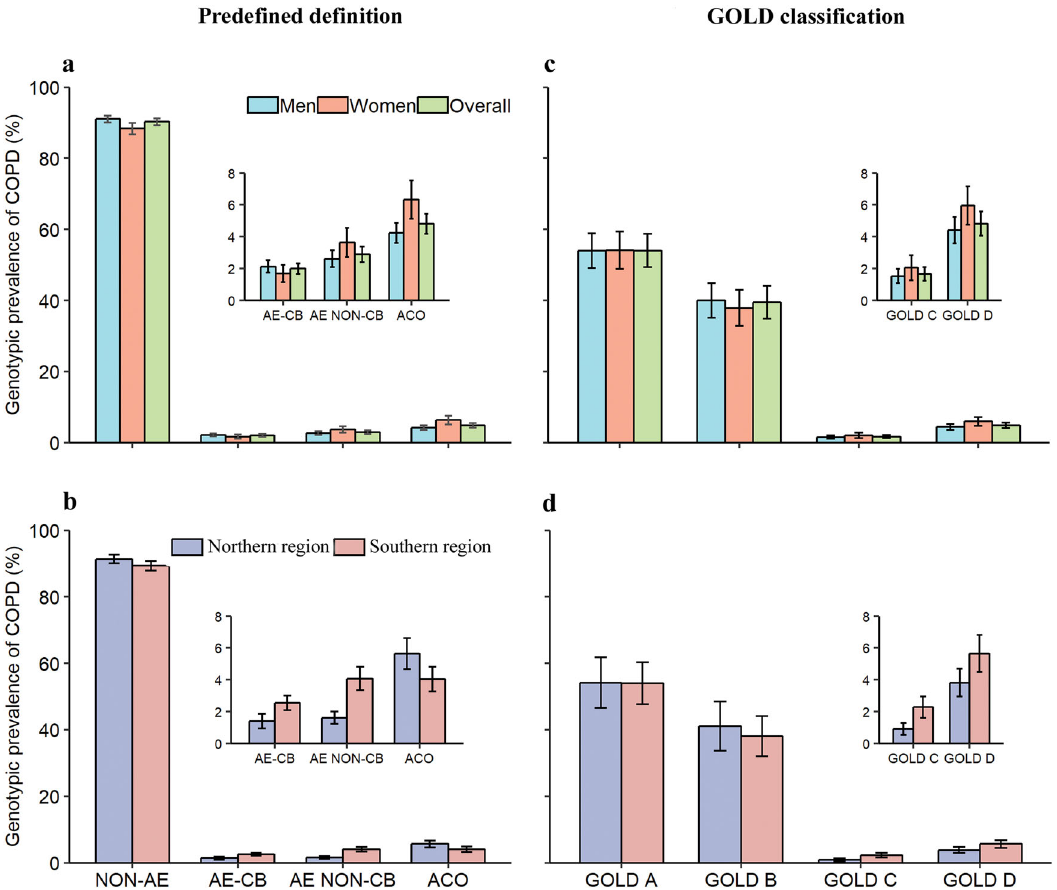
Fig. 2 The prevalence of chronic obstructive pulmonary disease phenotype by sex and geographic locations. a COPD phenotype prevalence with 95% CI by sex, prede fi ned de fi nition. b COPD phenotype prevalence with 95% CI by geographic locations, prede fi ned de fi nition. c GOLD classi fi cation prevalence with 95% CI by sex, GOLD classi fi cation. d GOLD classi fi cation prevalence with 95% CI by geographic locations, GOLD classi fi cation. Error bars represented the standard error of the prevalence and were estimated by Taylor series variances estimation approach. Abbreviations: COPD, chronic obstructive pulmonary disease; GOLD, Global Initiative for Chronic Obstructive Lung Disease; NON-AE, non-exacerbator; AE-CB, exacerbator with chronic bronchitis; AE NON-CB, exacerbator without chronic bronchitis; ACO, asthma-COPD